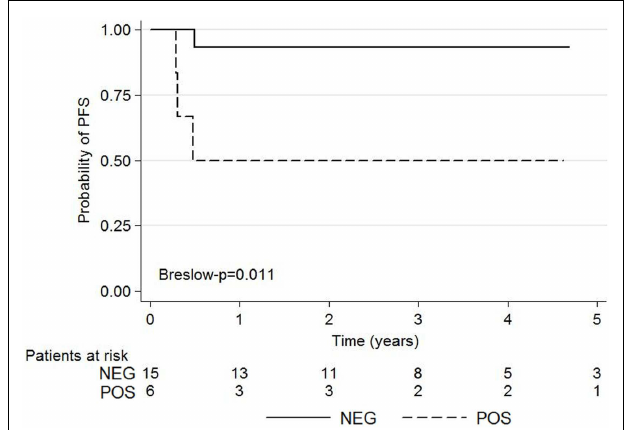
(22), response at interim 18 FDG-PET or CI did not predict PFS or overall survival in 34 patients with non-lymphoblastic lym- phomas including 28 B-cell lymphomas. In Carrillo-Cruz’s study (27), the Deauville criteria (score ≥ 4 as positive) did not allow to predict outcome accurately in a heterogeneous population of BL when quantitated at the end of treatment. On the contrary, in our study, the use of Deauville criteria (score ≥ 4 as positive) improved specificity and PPV and 18 FDG-PET was predictive of outcome ( p = 0.011) when performed in an earlier setting (after induction